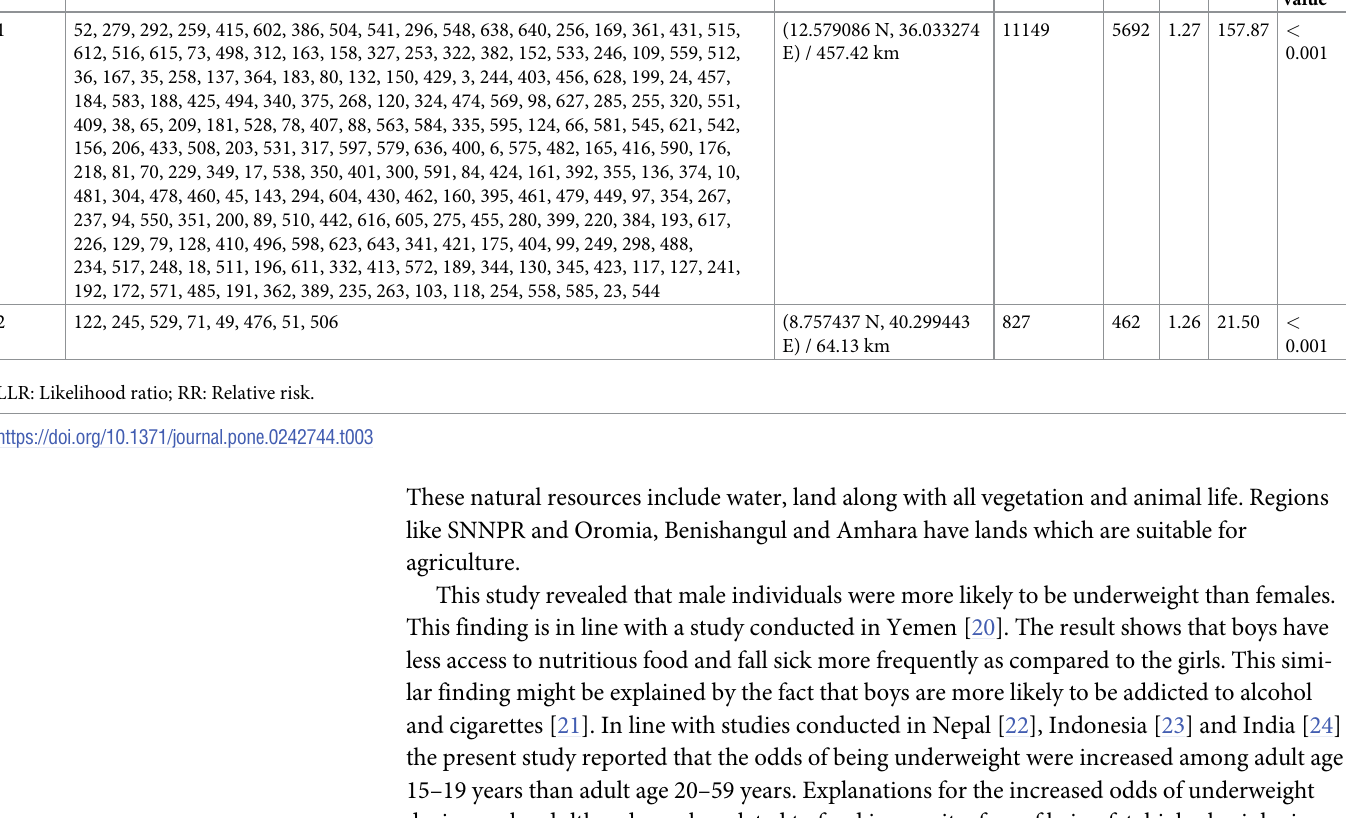
Table 3. Significant spatial clusters with high rate underweight among individuals age 15–49 years in Ethiopia, 2016. Cluster Enumeration area (cluster)